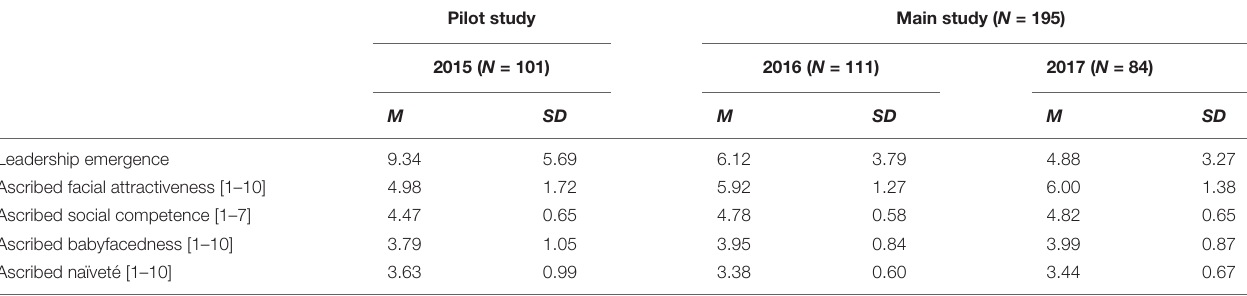
TABLE 1 | Descriptive statistics for the variables for both the pilot study and the main study, presented separately by contest year. Pilot